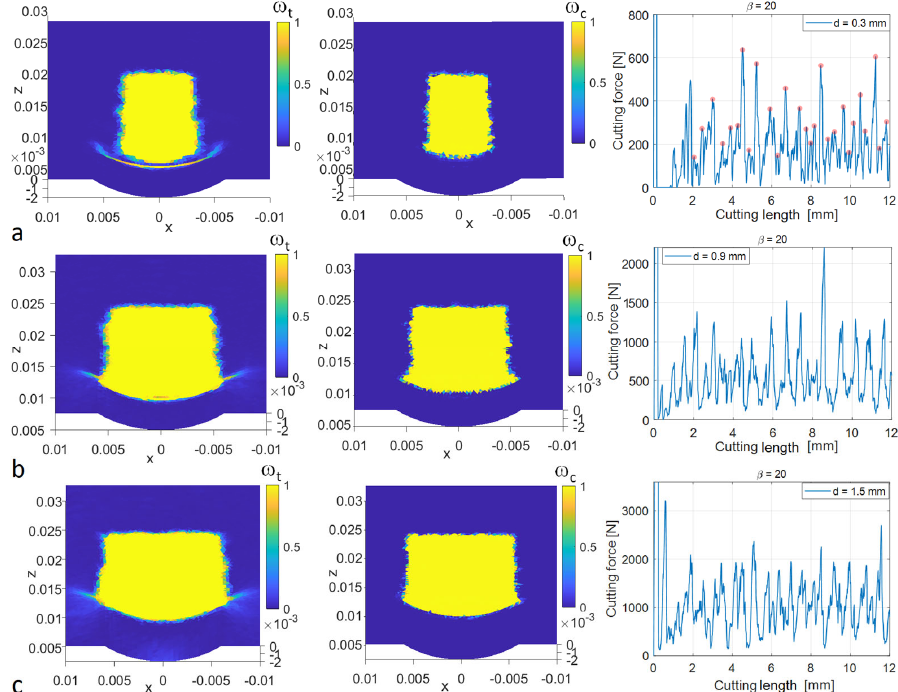
Figure 4. Simulation results for PDC cutting at different cutting depths: ( a ) tensile and compressive damage fields, and the cutting force for d = 0.3 mm (red dots mark the peaks included in calculating the average cutting force); ( b ) tensile and compressive damage fields, and the cutting force for d = 0.9 mm; ( c ) tensile and compressive damage fields, and the cutting force for d = 1.5 mm.